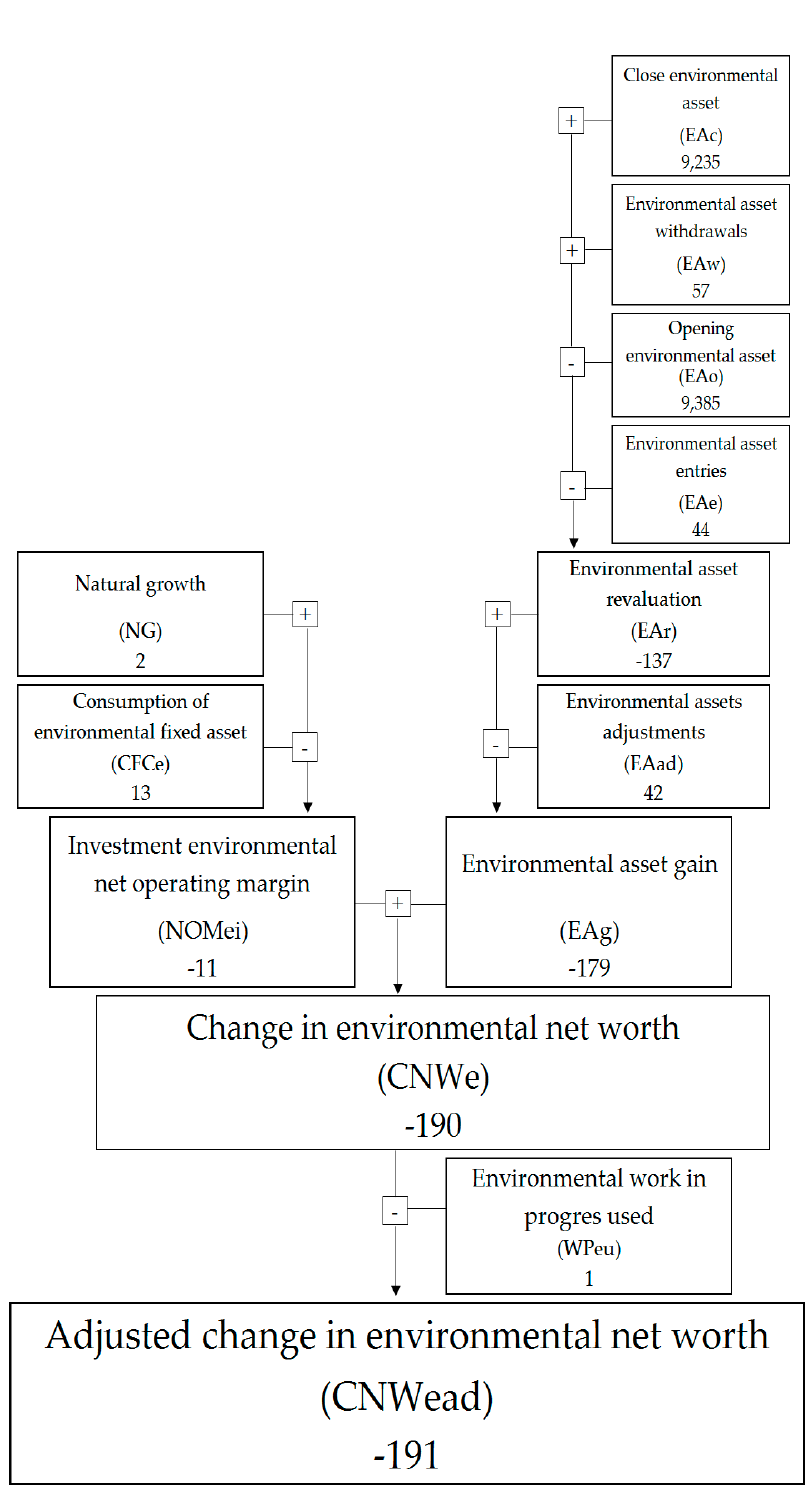
Figure 5. Agroforestry Accounting System adjusted change in environmental net worth for holm oak open woodlands in Andalusia (2010: €/ha).